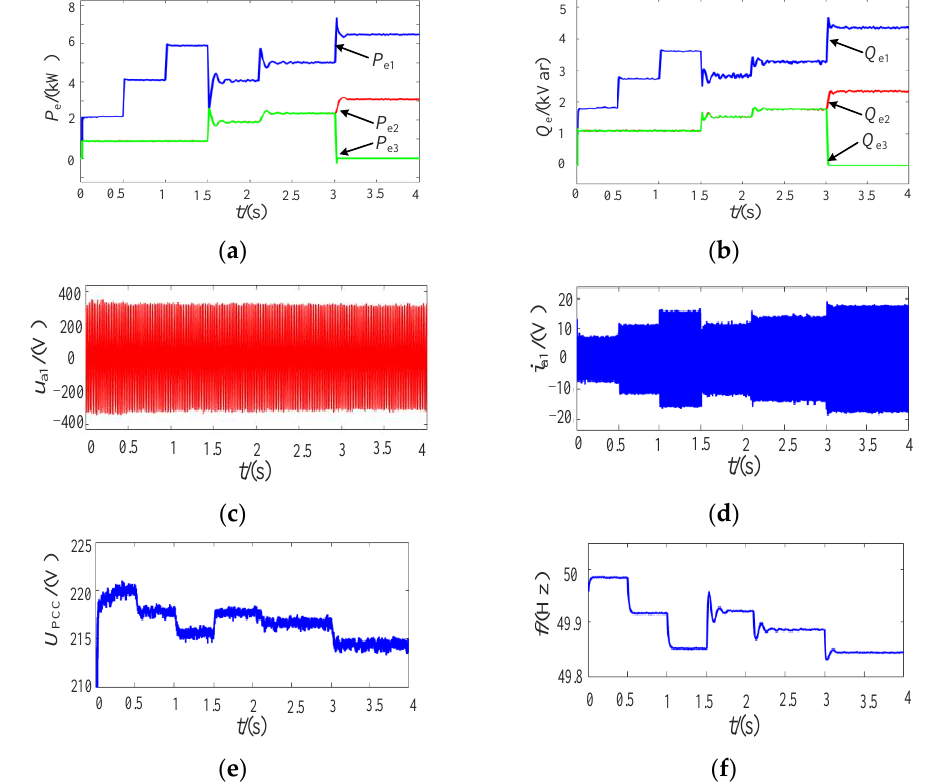
Figure 7. The diagram of the simulation result. ( a ) Active power output. ( b ) Reactive power output. ( c ) The A-phase output voltage of DG1. ( d ) The A-phase output current of DG1. ( e ) RMS of PCC. ( f ) Output frequency of the system.